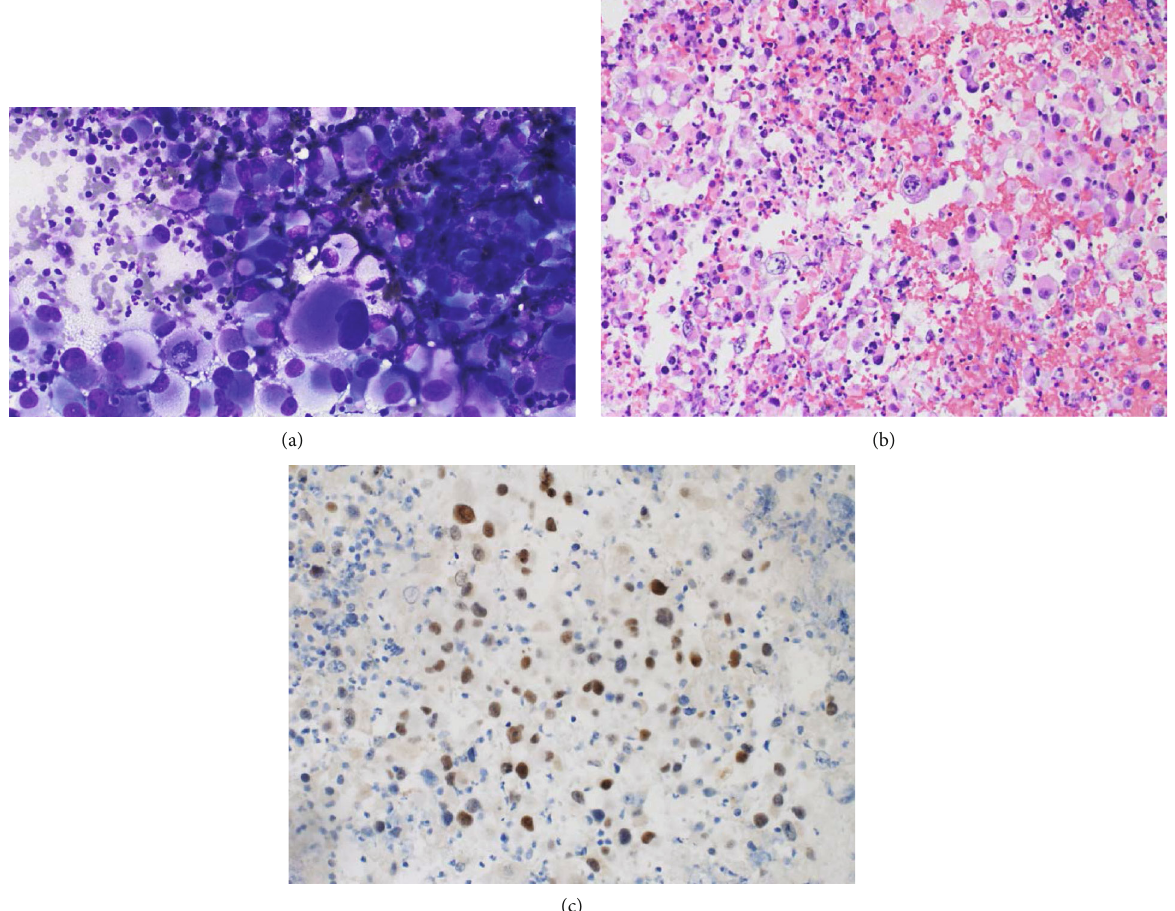
Figure 2: Fine needle aspiration from retroperitoneal lymph node biopsy. (a) Cytologic preparation (40x magni fi cation) showing abundant large, pleomorphic tumor cells consistent with renal cell carcinoma. Small lymphocytes and neutrophils are present in the background for scale. (b) Cell block (20x magni fi cation) demonstrating tumor cells with signi fi cant nuclear pleomorphism. Some cells have rhabdoid features with an eccentric nucleus and abundant eosinophilic cytoplasm. (c) PAX8 immunohistochemical staining is positive in the tumor cells, highlighting the renal